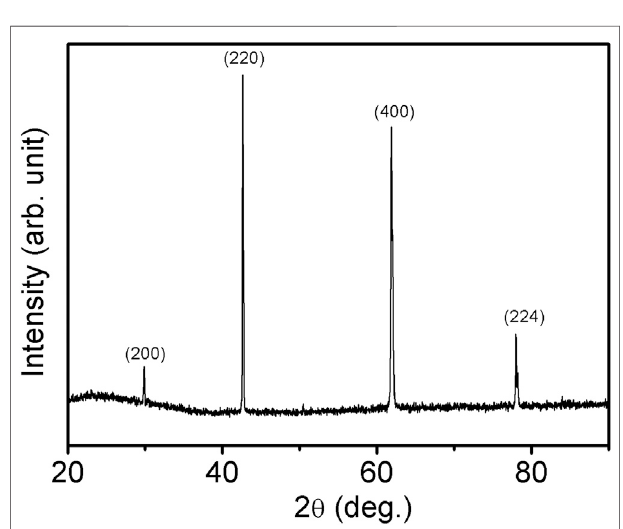
FIGURE 2 | Room temperature XRD pattern for the Mn 50 Ni 50-x Sn x (x (cid:2) 10) Heusler alloy melt spun ribbons.